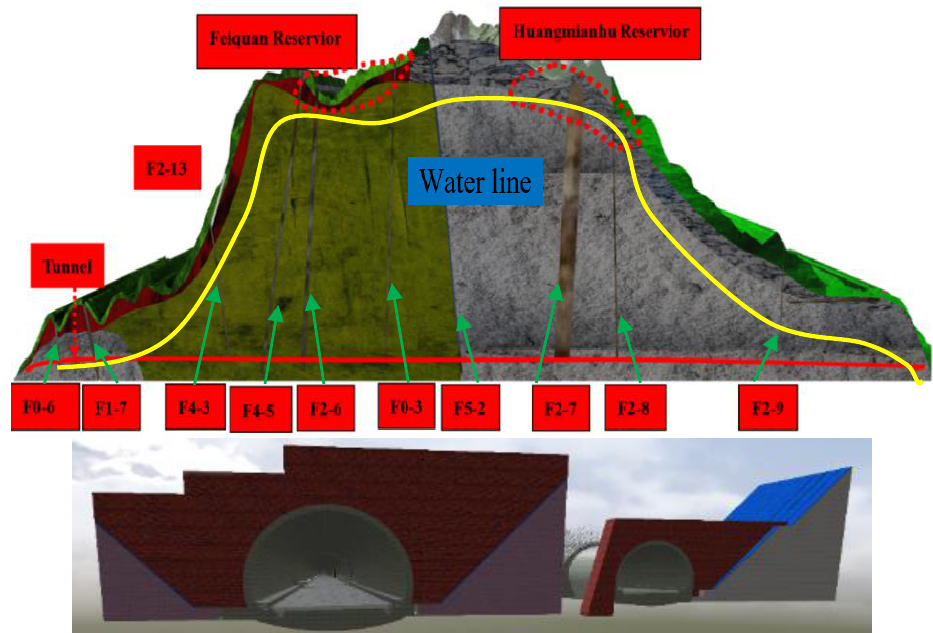
Figure 7. Geological topographic map.( F is the fault mark.)